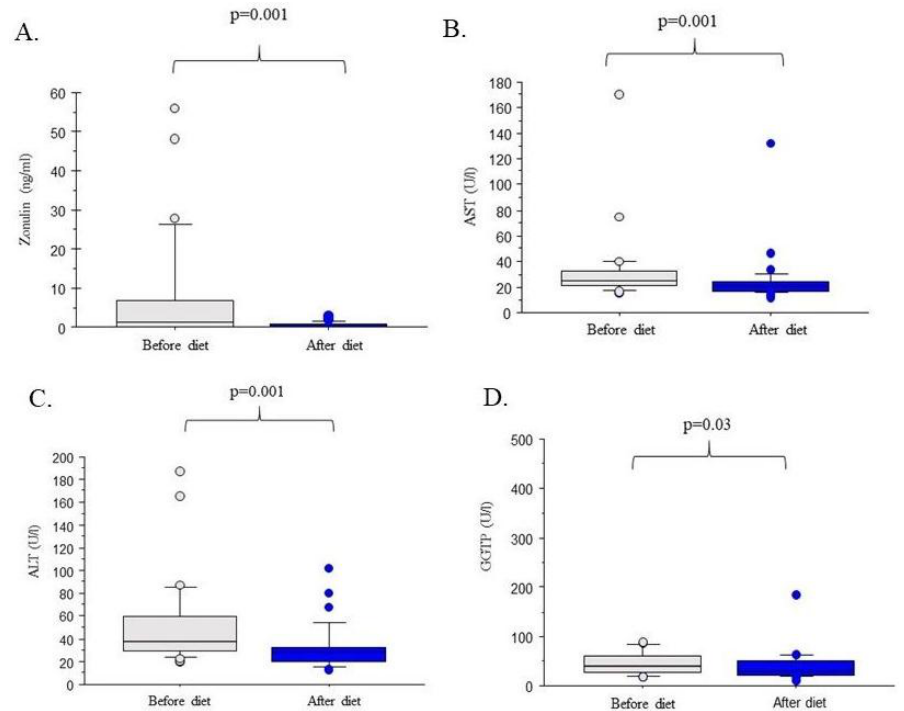
Figure 2. Zonulin concentration and liver function tests before and after the dietetic intervention. A . Zonulin concentration. B . Aspartate aminotransferase (AST) activity. C . Alanine aminotransferase (ALT) activity. D . Gamma-glutamyltransferase (GGTP) activity.